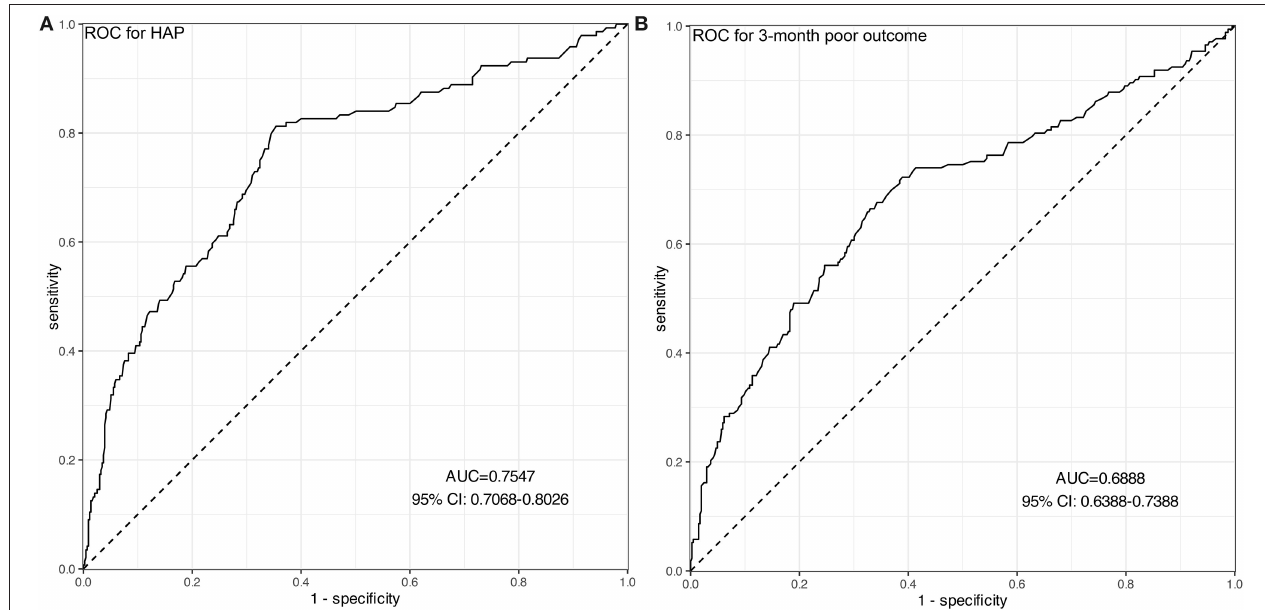
FIGURE 3 | ROC curves of Hcy for predicting HAP (A) and 3-month poor outcomes (B) . (A) The AUC of Hcy was 0.755 with 95% CI: 0.707–0.803 ( p < 0.001), indicating a moderate predictive ability for the development of HAP. (B) The AUC of Hcy was 0.689 with 95% CI: 0.639–0.739 ( p < 0.001), indicating a moderate predictive ability for 3-month poor